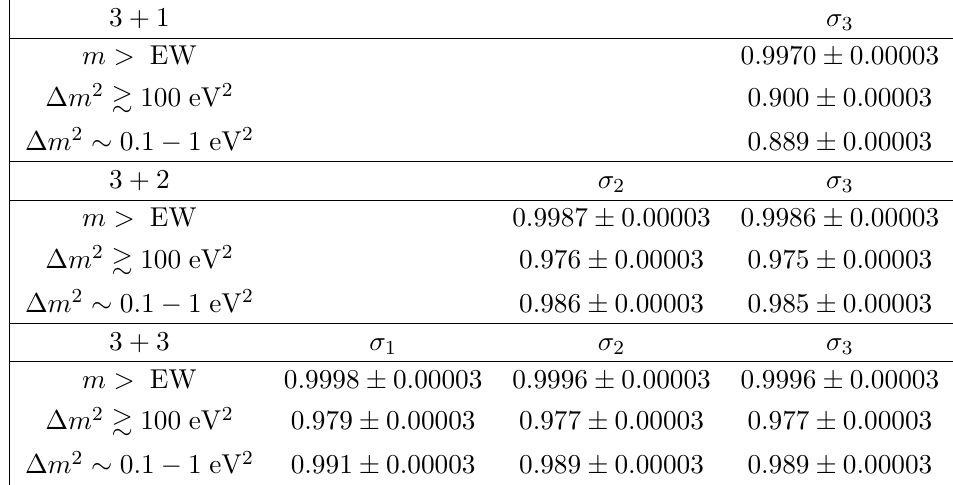
Table 3 . The smallest possible values of (cid:27) i for di(cid:11)erent mass schemes in 3 + N scenarios. The estimated error 3 (cid:1) 10 (cid:0) 5 is written explicitly and is the same for all